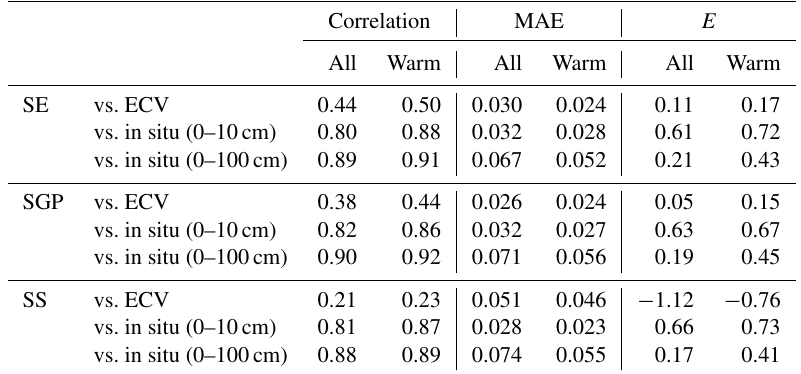
Table 3. Evaluation of CMIP5 ensemble over the Southeast, Southern Great Plains and Southern Shrubland using all monthly soil moisture and warm-season-only soil